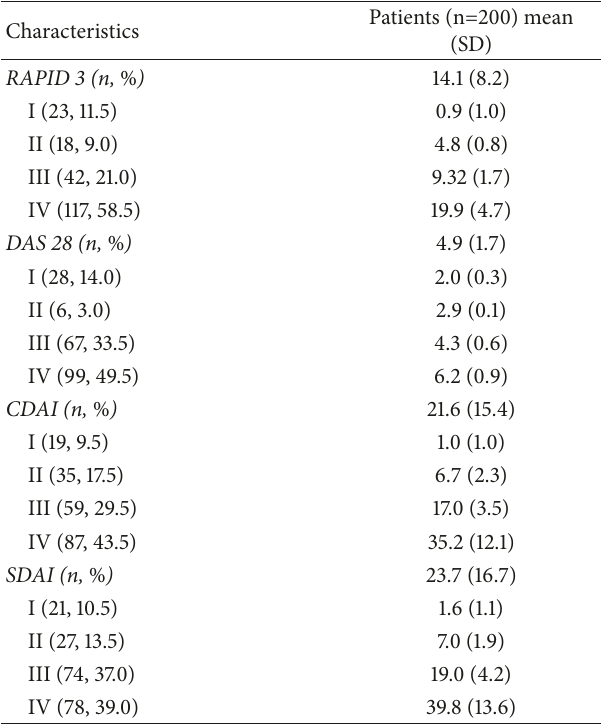
Table 1: Demographic and clinical information of studied popula- tion.